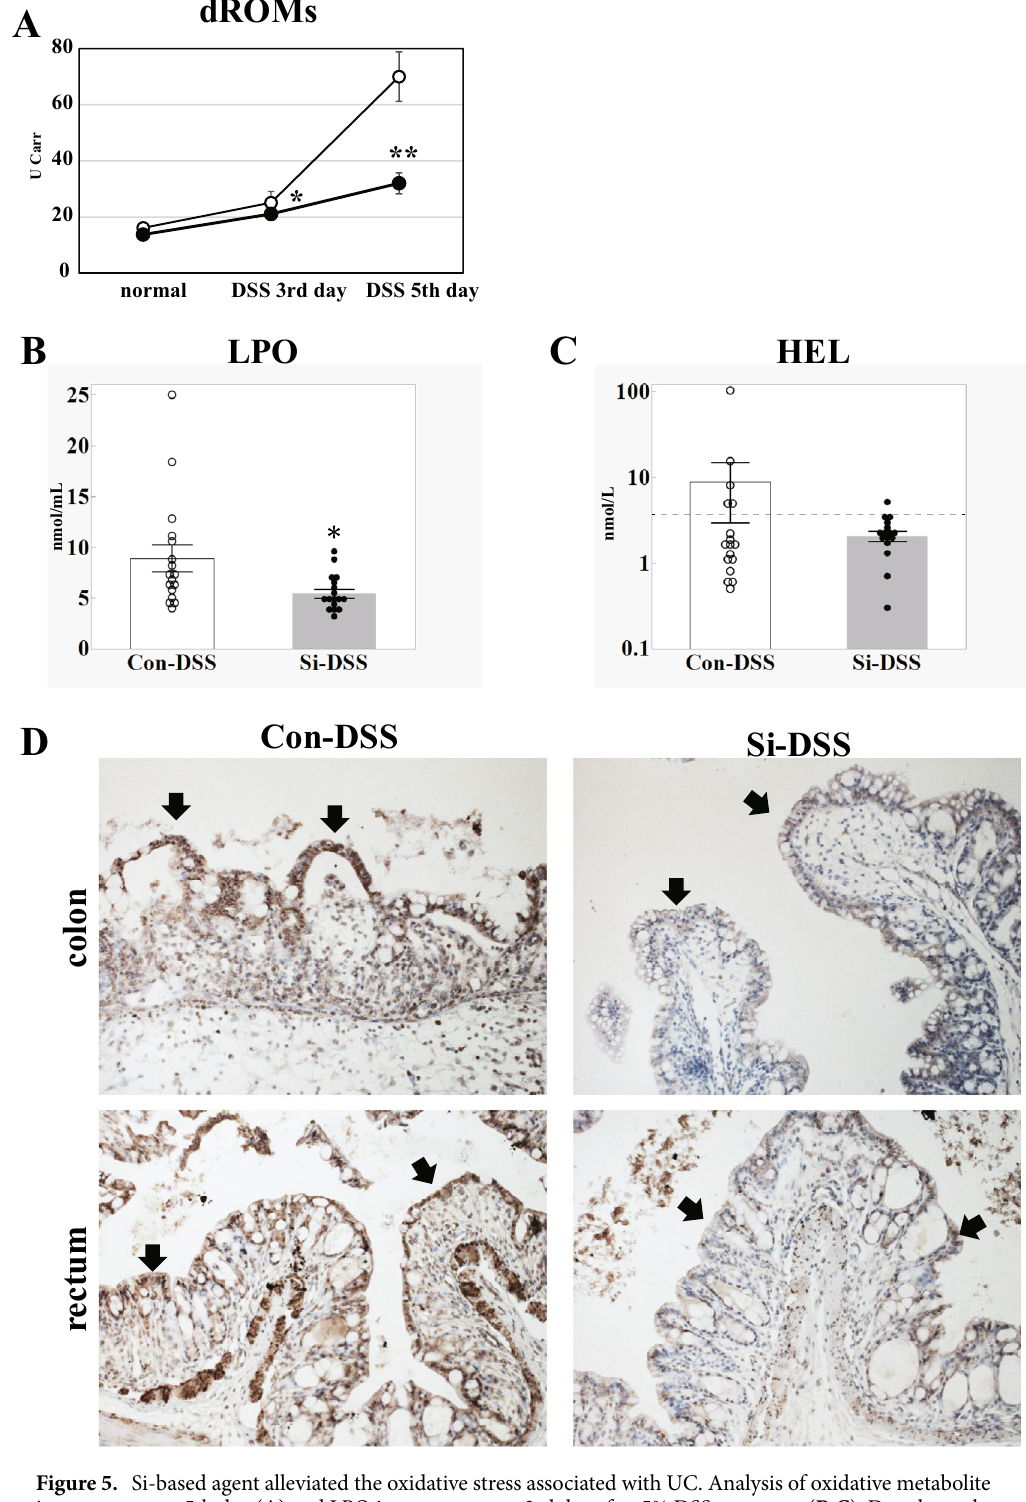
Figure 5. Si-based agent alleviated the oxidative stress associated with UC. Analysis of oxidative metabolite in mouse serum 5th day ( A ) and LPO in mouse serum 3rd day after 5% DSS treatment ( B , C ). Day-dependent changes in the mean of the dROMs value ( A ). Bar chart indicates the mean values. LPO lipoperoxide ( A ) and HEL Nε-(hexanoyl)lysine ( B ). The dot line in ( B ) indicates the detection limit for HEL (3.0). The positive rates for HEL were 29.4% (Con) and 17.6% (Si). White: Con or Con-DSS group. Black: Si or Si-DSS group. Data are expressed as mean ± SEM of 8 ( A : normal), 9 ( A : DSS 3rd and 5th day) and 17 mice ( B , C ) per group. * p < 0.05, * p < 0.05 vs. control, determined by Student’s paired t -test ( A – C ). Analysis of LPO accumulation on the 5th day after DSS administration using immunohistochemistry with anti-4-HNE antibodies ( D ). The representative photographs of the colon (upper) and the rectum (bottom) in the Con-DSS group (left) or Si-DSS group (right). Black arrows: epithelial cells. Scale bar: 50